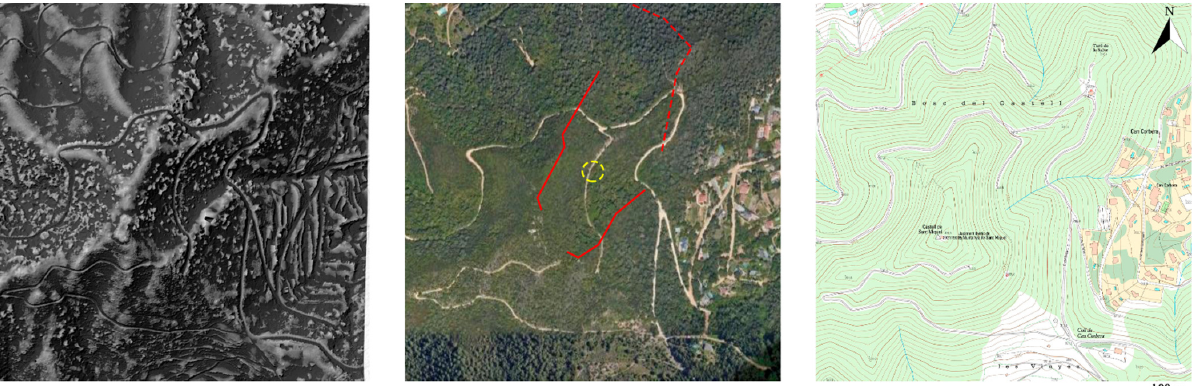
Figure 12. MSRM ( left ), satellite view ( centre ) and topographic map ( right , forest in green) of the Sant Miquel site. In the satellite image the walls (red) and the known location of the settlement (yellow) are indicated.